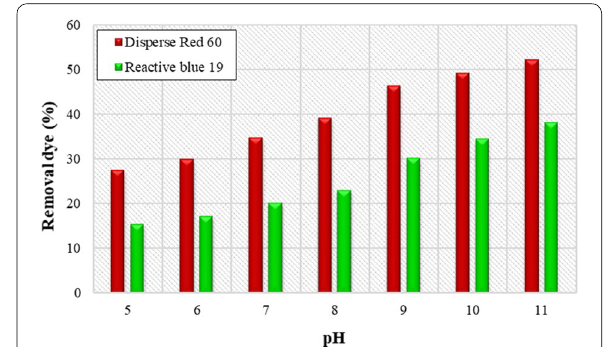
Fig. 2 The effect of initial pH on the efficiency of removal of Disperse red 60 and Reactive blue 19 dyes. ( Alcea rosea concentration 40 mg/L) =